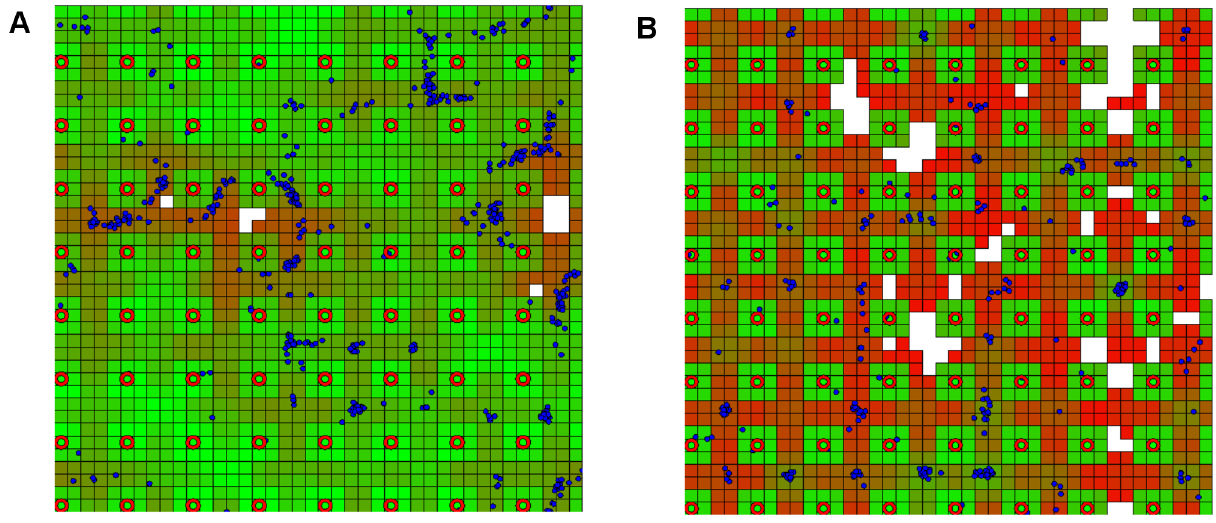
Figure 7. Simulation snapshots after 2000 steps. Green squares represent healthy epithelial cells, red squares represent damaged epithelial cells, red circles represent blood vessels, blue circles represent macrophage, and white squares represent the dead cells. Panel (A) shows the simulation result for the control group with the pressure interval=210. Panel (B) shows the simulation result for the SCI group with the pressure interval=107.